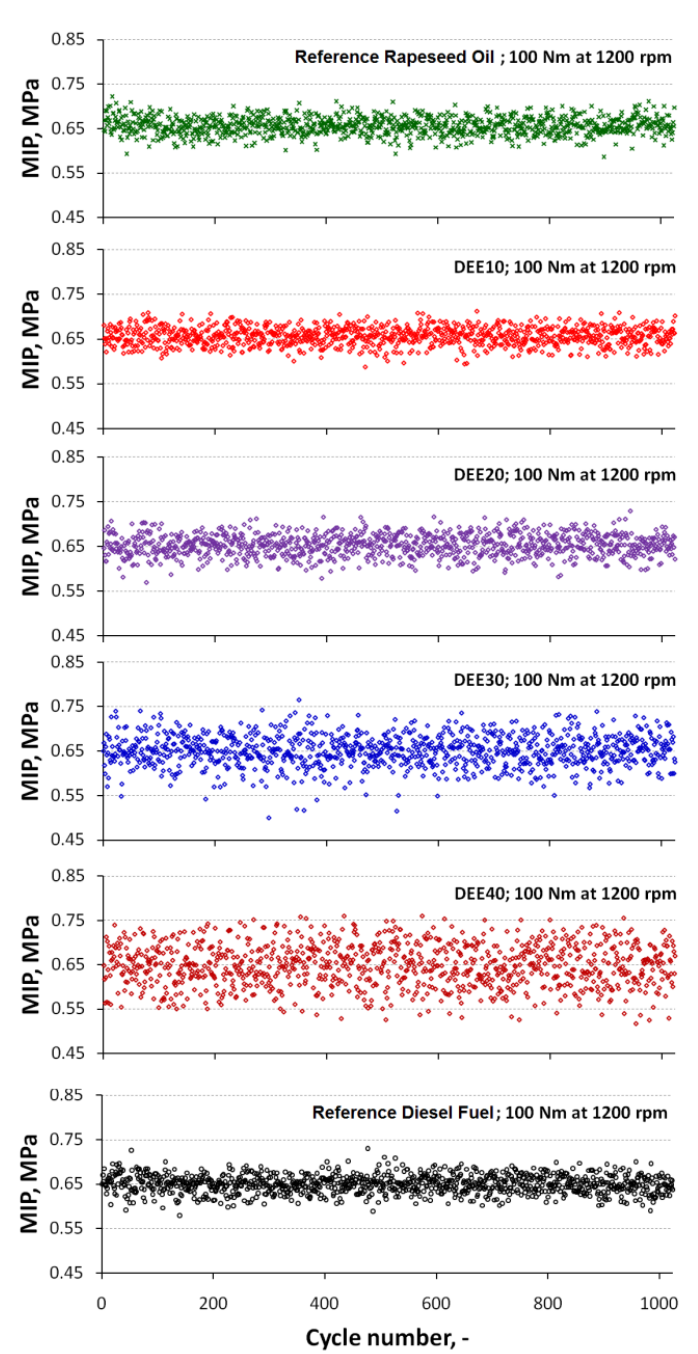
Figure 4. MIP calculated for 1024 consecutive cycles recorded for the AD3.152 engine fueled with tested fuels, operated with 100 Nm at 1200 rpm.